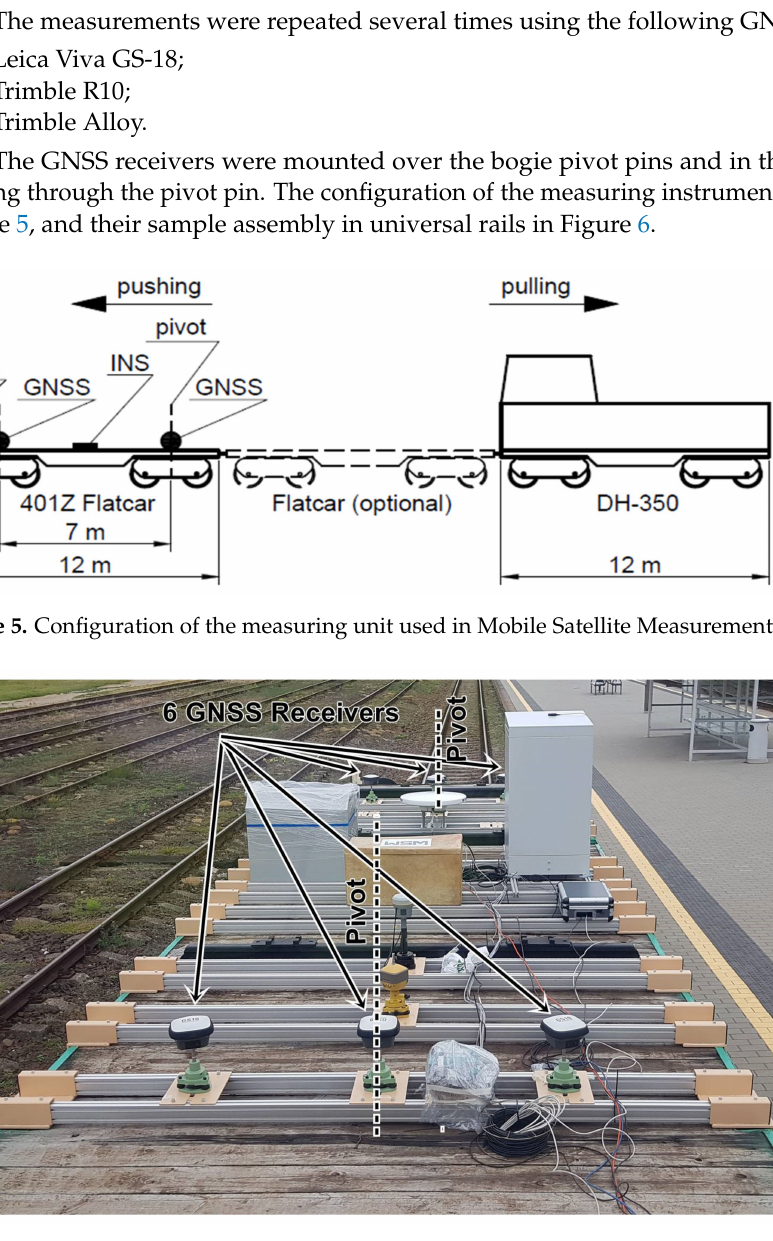
Figure 6. Measuring instruments mounted in universal